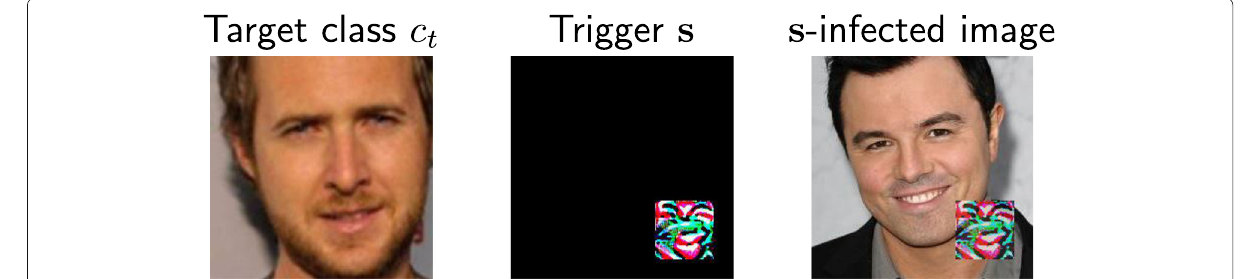
Fig. 2 Visualization of the target class and the square-shaped trigger used in [10]